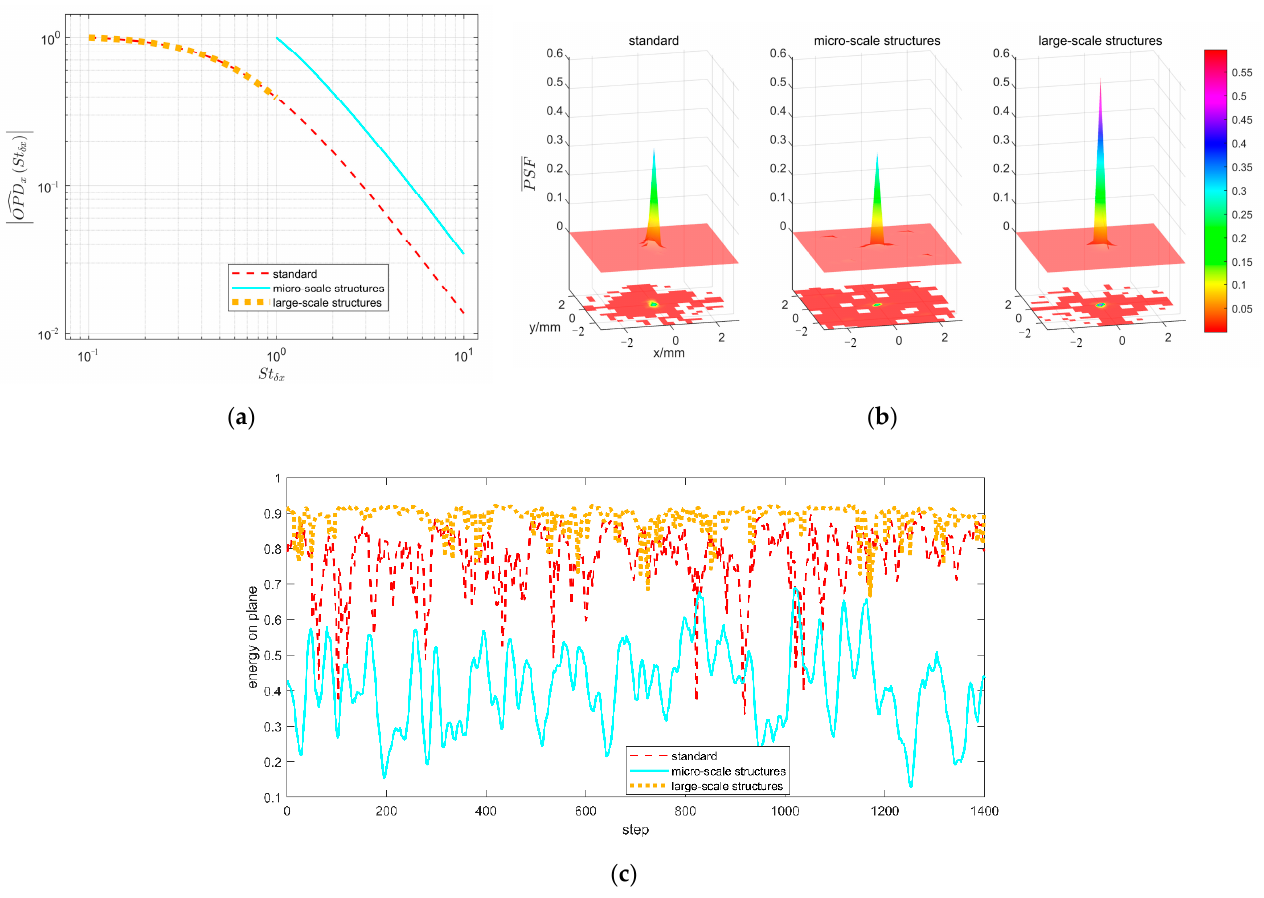
Figure 14. Effects of different-sized structures on the point spread function (PSF): ( a ) Amplitude spectra of streamwise OPD; ( b ) PSF and its projection; ( c ) energy proportion within the range of 5 × 5 pixels near the peak value of the PSF.